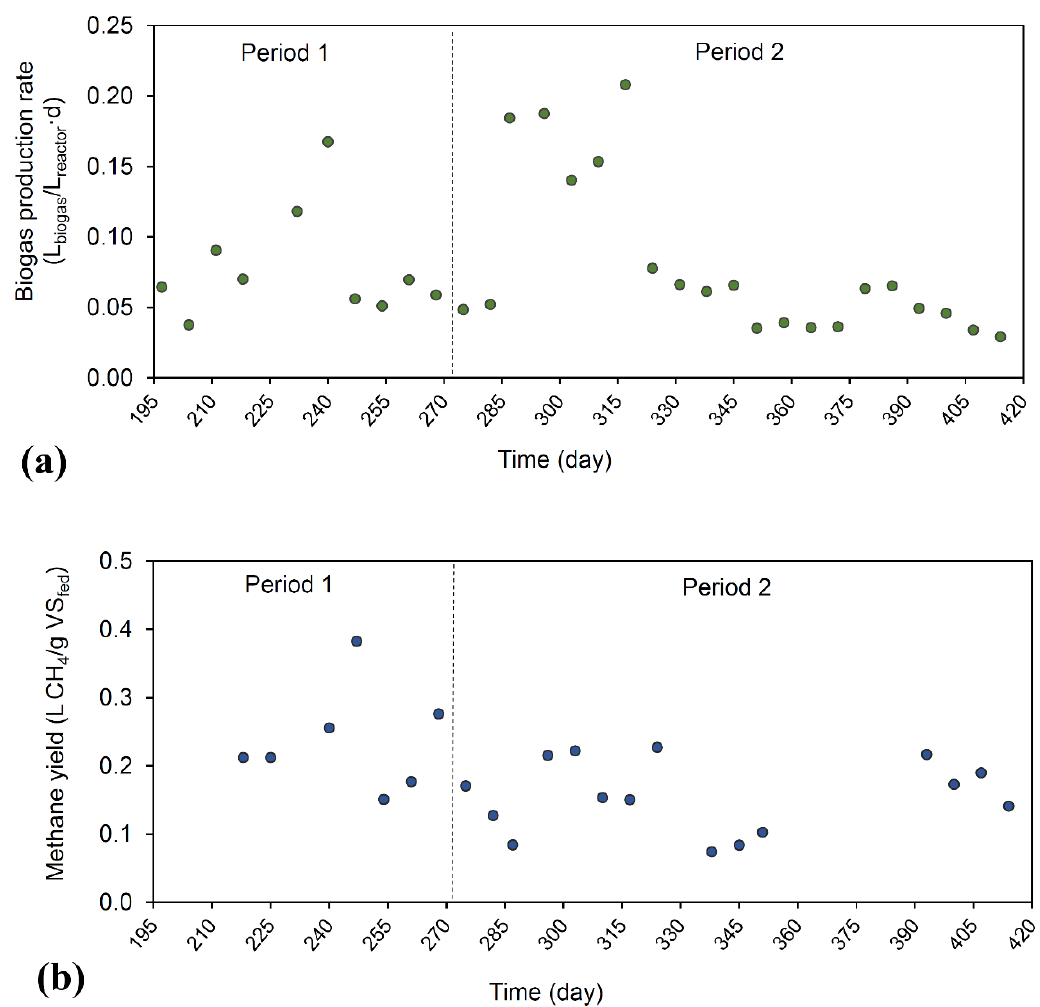
Figure 6. Biogas production rate ( a ) and methane yield ( b ) over the experimental periods 1 (HRT of 20 days) and 2 (HRT of 32 days).